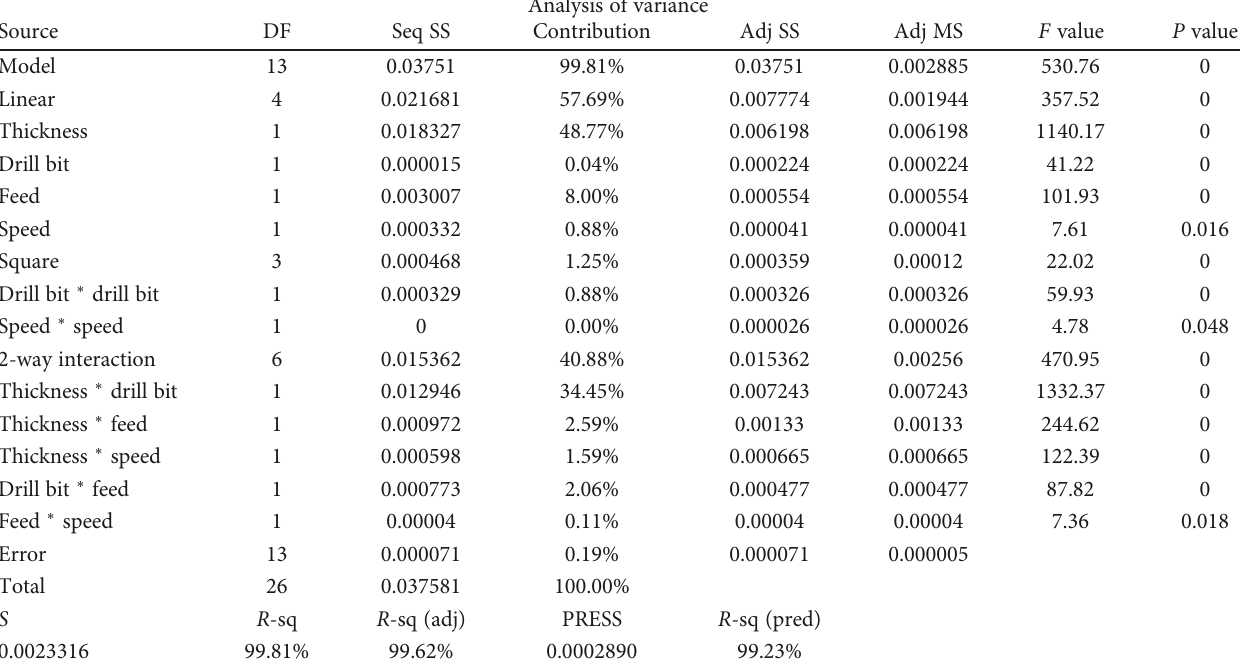
Table 5: ANOVA analysis for delamination entry.